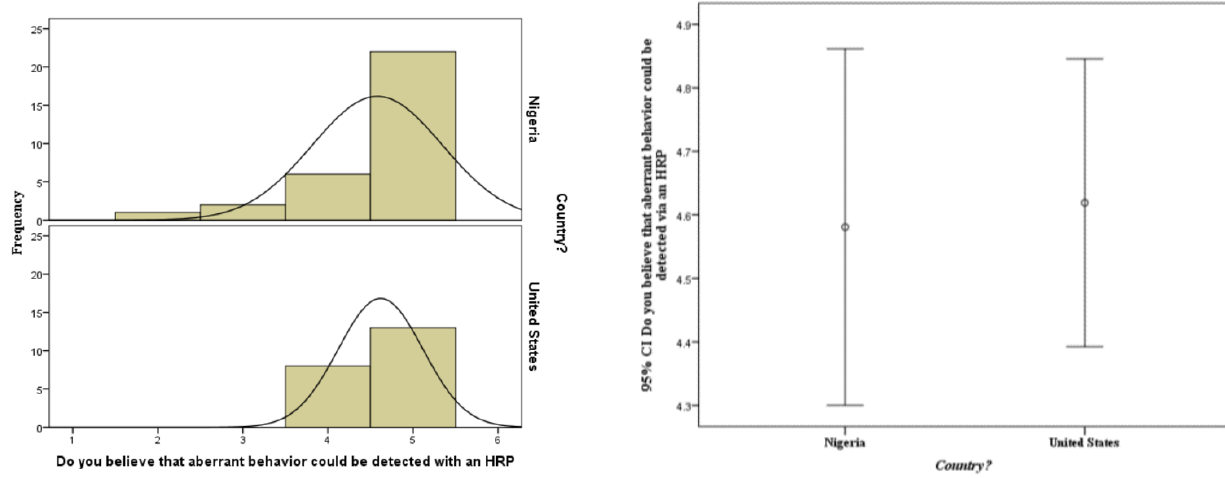
Figure 8. Aberrant behavior detection via an HRP